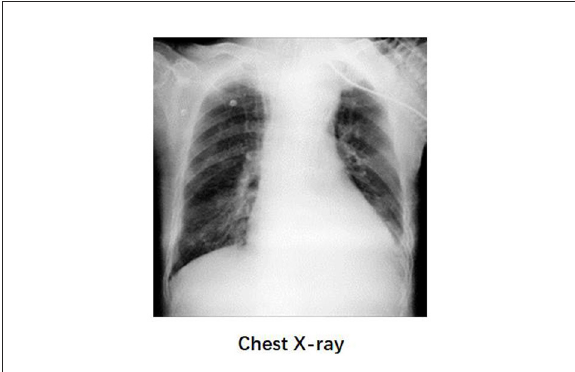
FIGURE4 The chest X-ray of patient. Chest radiography did not show signs of pneumothorax. Functional EIT images of ventilation showed that the defect of the left lung had been restored after